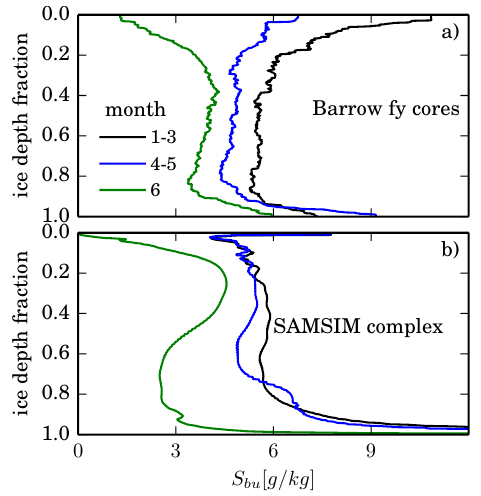
Figure 10. Time-averaged and vertically normalized salinity pro- files from first-year ice cores (described in Sect. 4.3 and shown in a ) and first-year ice from reanalysis forced simulations using the com- plex brine dynamic parametrizations (b) . Both were averaged from January to March (1–3), April to May (4–5), and over June